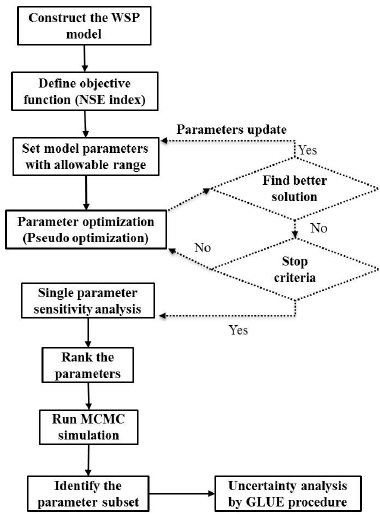
Figure 1. Flowchart of the model development process.